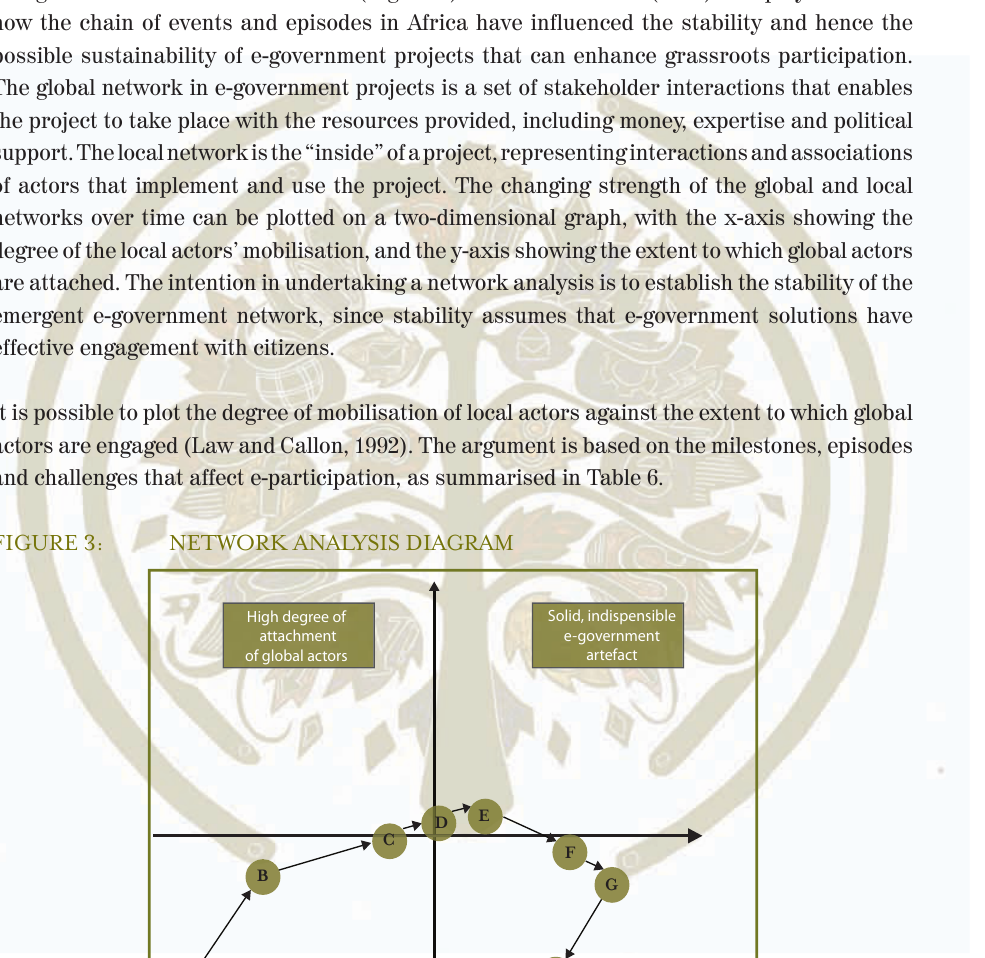
H High degree of mobilisation of local actors